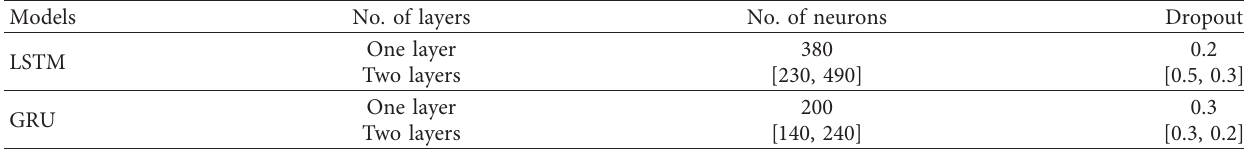
Table 4: The best value parameters of DL for death cases in Egypt.